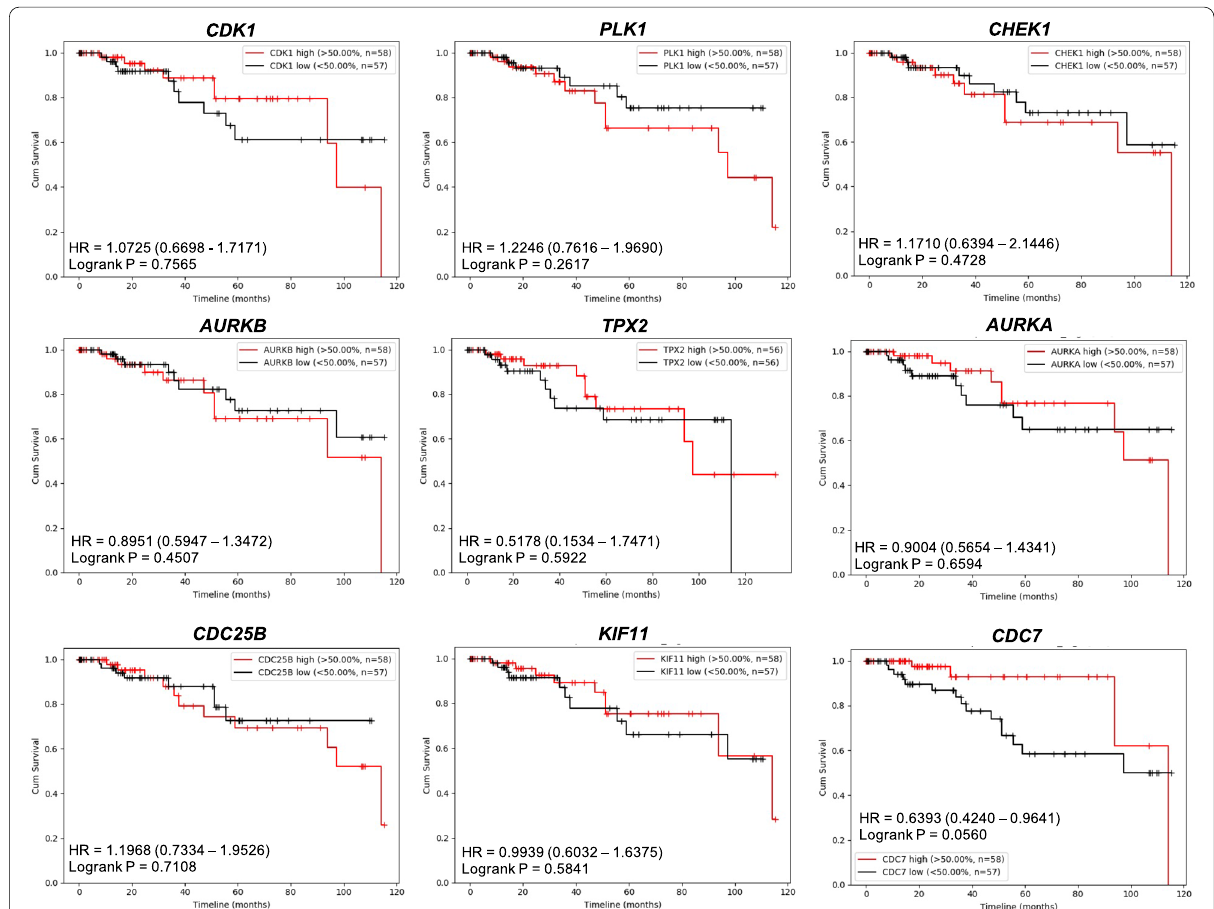
Fig. 5 The overall survival analysis from AURKB , PLK1 , CDK1 , TPX2 , AURKA , KIF11 , CDC7 , CHEK1 , and CDC25B genes in triple negative breast cancer